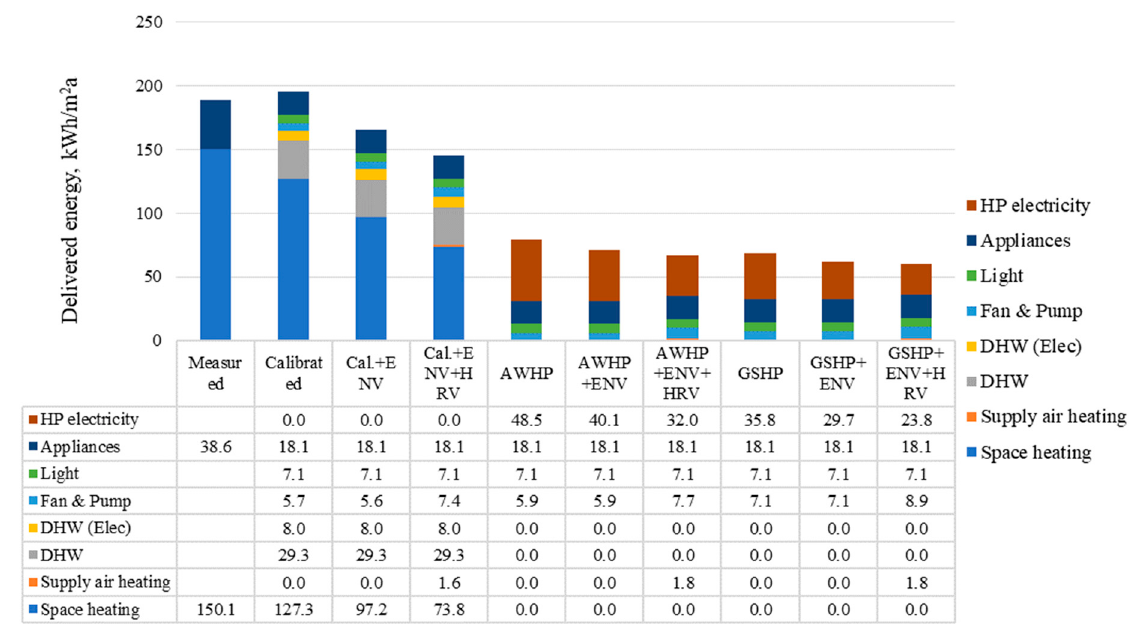
Figure 5. The delivered energy use of a reference single-family house in simulated renovation measures.